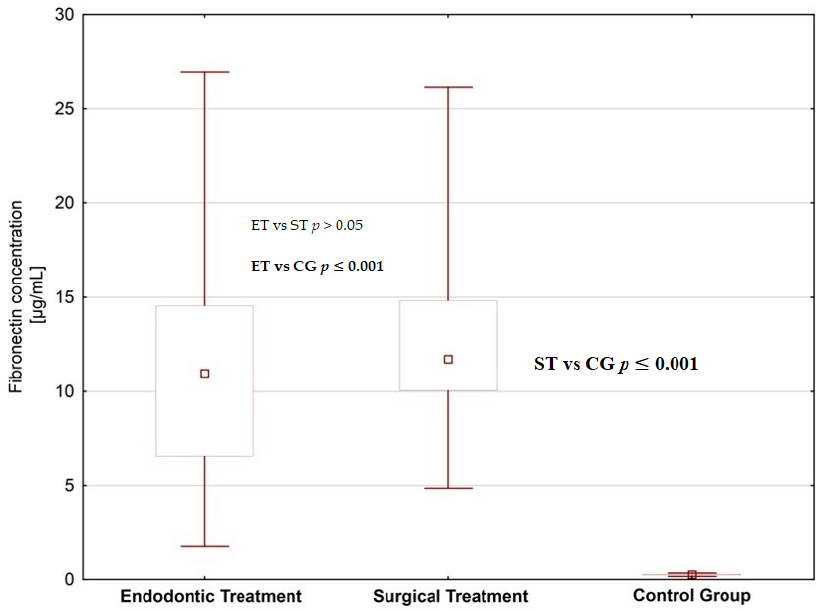
Figure 3. Saliva Fibronectin concentrations in patients planned for endodontic and surgical dental treatment in comparison to the control group. Table 1. The statistical parameters of MMP-1 and MMP-2 concentrations in saliva before and after dental treatment.